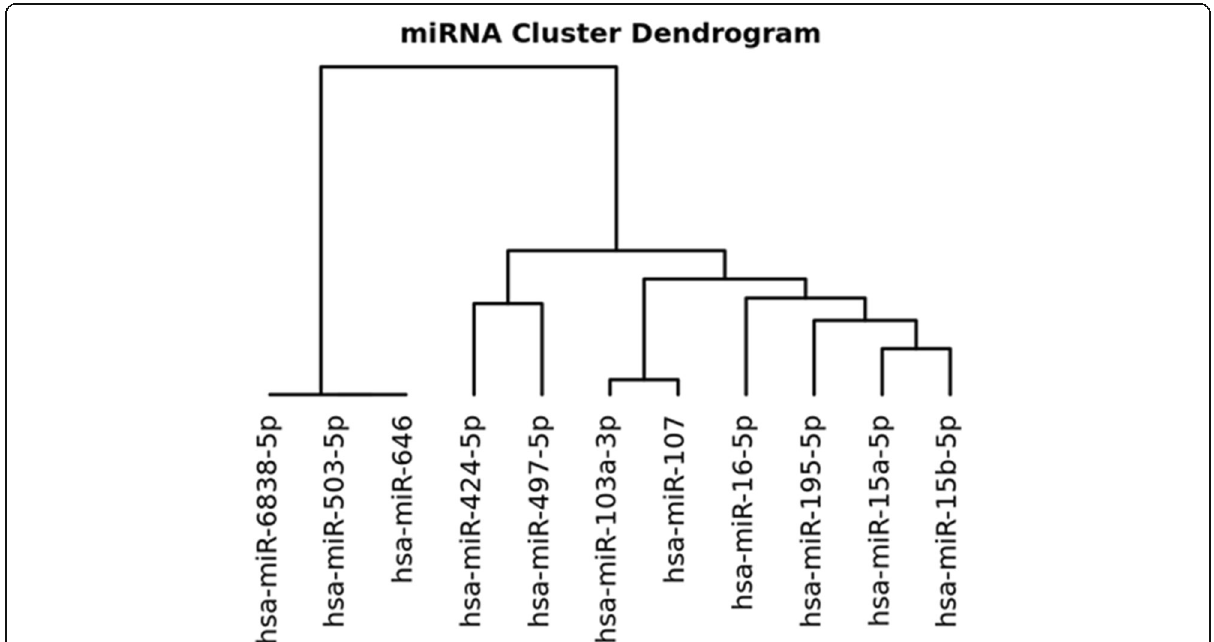
Fig. 2 Cluster dendrogram of miR-15/107 family according to the overlapping miRNA-target gene relationship archived in TarBase (a database for experimentally validated miRNA-target gene recognition)